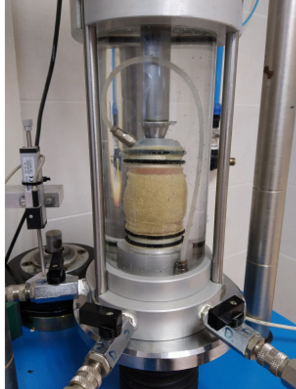
Figure 7. Silica sand sample subjected to pressure in a triaxial